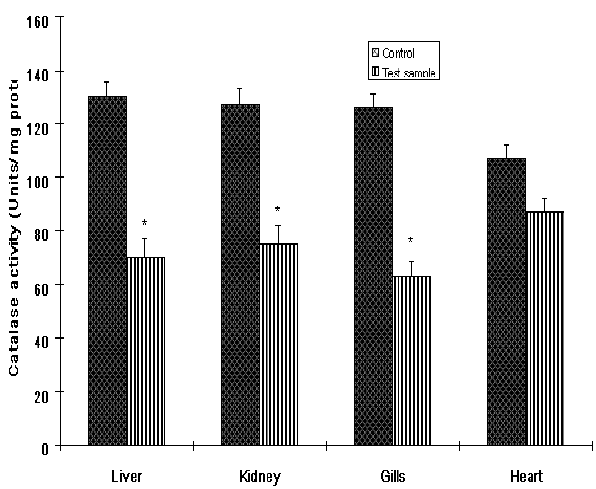
4 Figure 2: The activities of catalase (CAT) in the livers, kidney, Gills and heart of Clarias gariepinus from Ogun River and Agodi farm. Values are mean ± SD of 10 fishes. Significantly different from control,* p<0.001